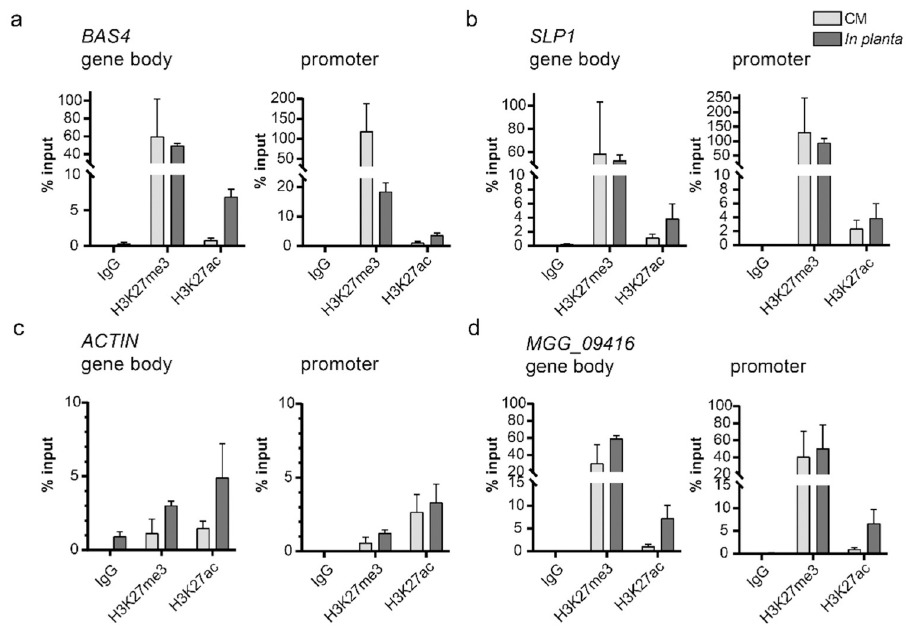
Fig 7. H3K27 modifications undergo dynamics at specific genomic locations in planta . (A-D) The amount of DNA associated with H3K27me3 and H3K27ac was determined relative to the amount of input DNA (% Input) from M . oryzae during axenic growth (CM) and during plant infection ( in planta ). A control ChIP sample was conducted where the IgG antibody was used for the pull-down (IgG sample) and did not produce a significant signal for any primer pairs tested. For each gene locus, one primer pair was designed in the gene body while the was designed in the promoter (i.e. 200–300 bp in front of the transcription start site). (A) BAS4 locus, (B) SLP1 locus, (C) ACTIN locus, and (D) MGG_09416